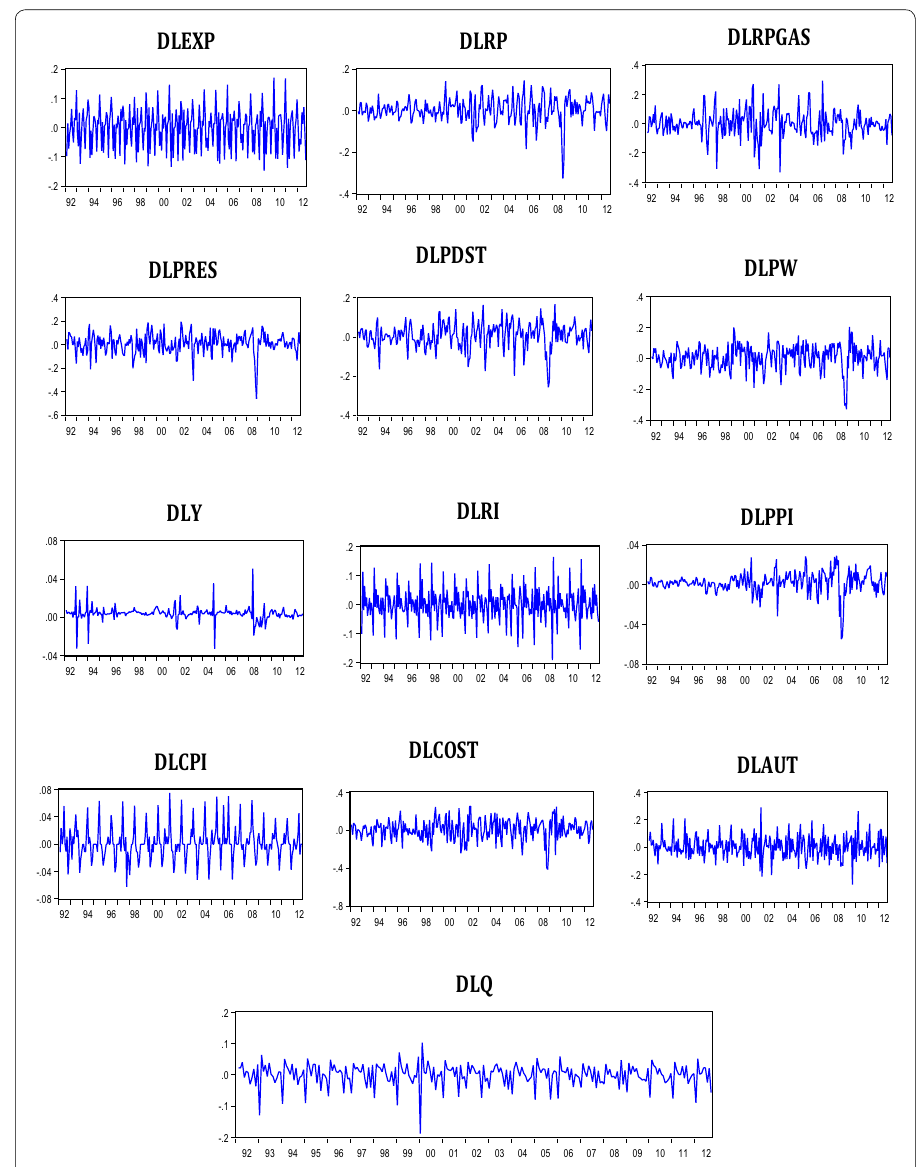
Fig. 3 Plot of DLEXP, DLRP, DLRPGAS, DLPRES, DLPDST, DLPW, DLY, DLRI, DLPPI, DLCPI, DLCOST, DLAUT and DLQ in the